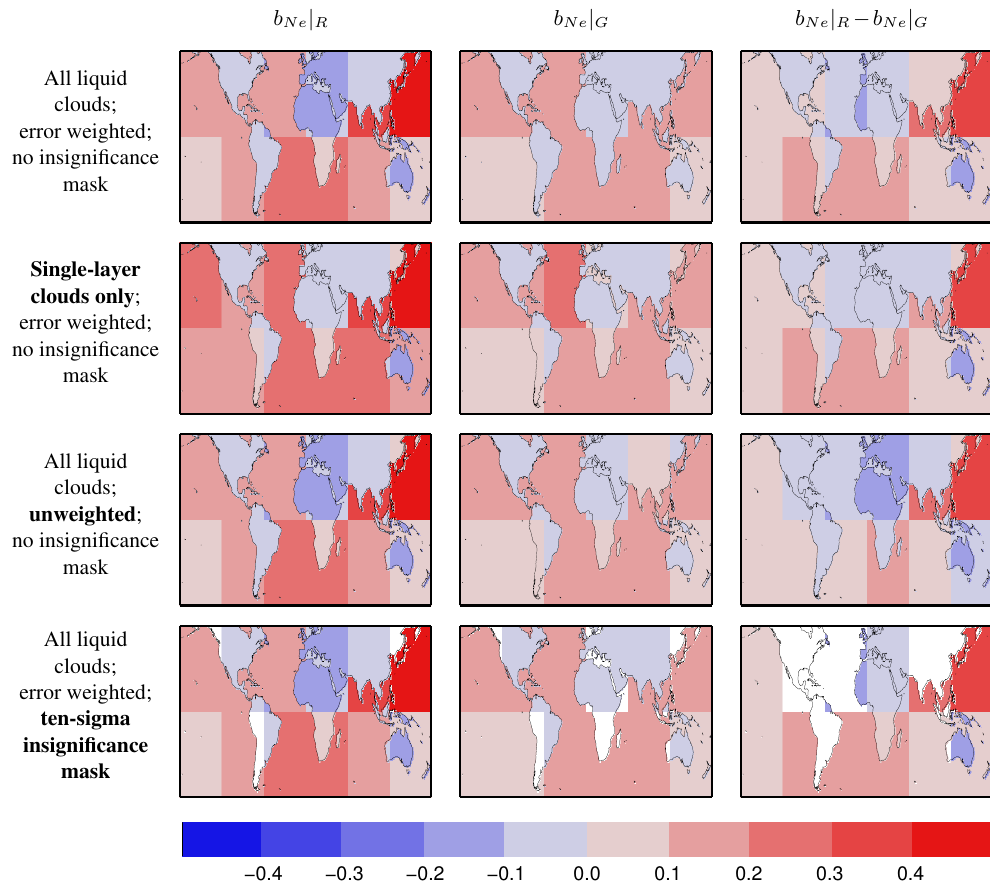
Fig. 1. Annual mean sensitivity of single-layer-only N e to τ a for regions of size 60 ◦ × 60 ◦ . The first column shows the results for the region-method; the second column is for the grid-method; the third column is the difference between the region-method and grid-method sensitivities. The first row shows the results for when the single-layer cloud constraint is not applied to the calculation of N e and for when one-sigma error weighting is used to combine sensitivities for 1 ◦ × 1 ◦ grid boxes to 60 ◦ × 60 ◦ regions (grid-method) and sensitivities for individual seasons to annual means (both methods), like the b Ne results shown in Fig. 3; the second row shows the results for when the single-layer cloud contraint is applied to the calculation of N e ; the third row shows the results for when error weighting is not used. No insignificance mask has been applied here. Grey represents missing data.